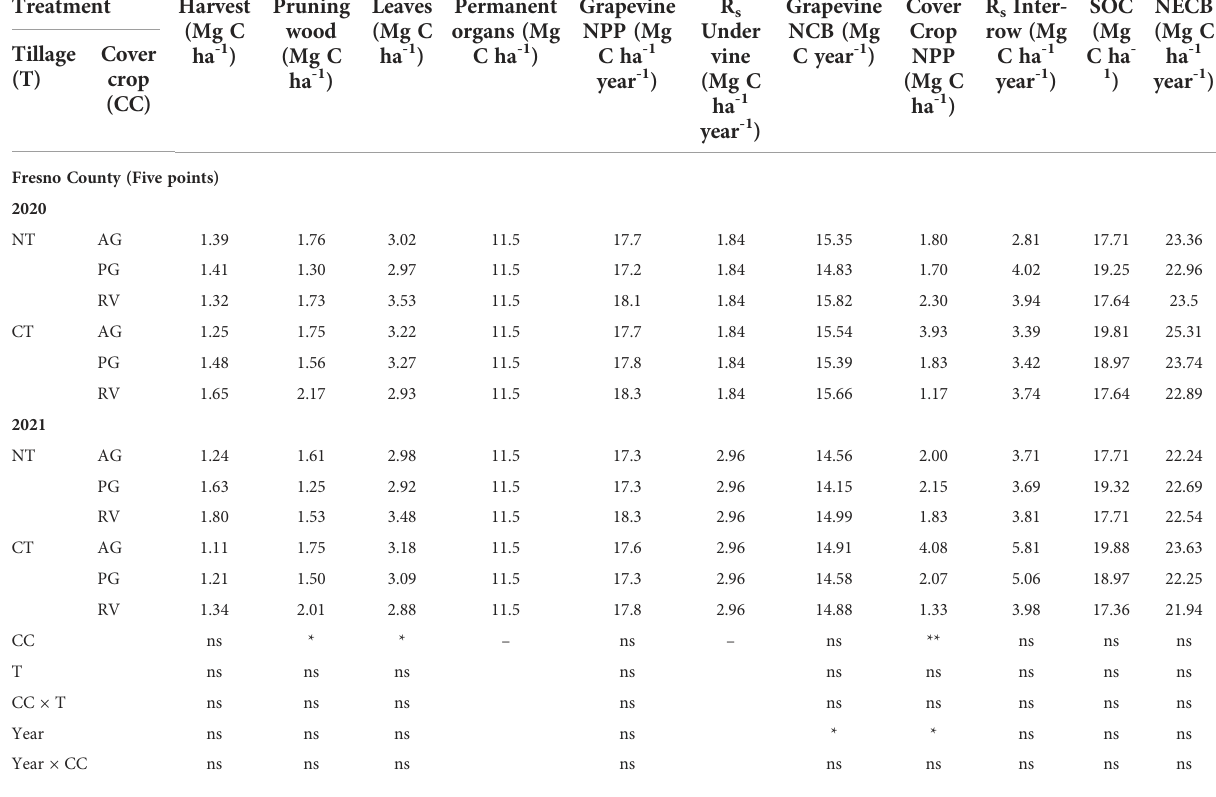
TABLE 4 Components of the vineyard ’ s net primary production (NPP as t ha -1 of dry matter), the whole vine ’ s net carbon balance (NCB), and the vineyard ’ s net ecosystem carbon balance (NECB) calculated over the 2-year study for six different cover crop and tillage systems. a,b .